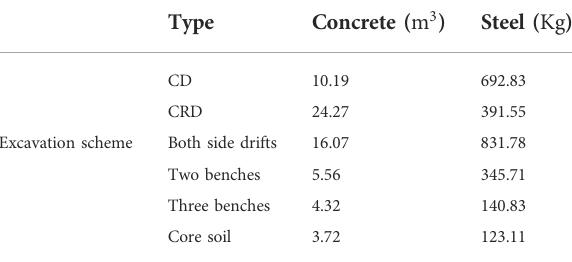
TABLE3Referencevaluesofaverage concreteandsteel consumption per linear meter for different excavation